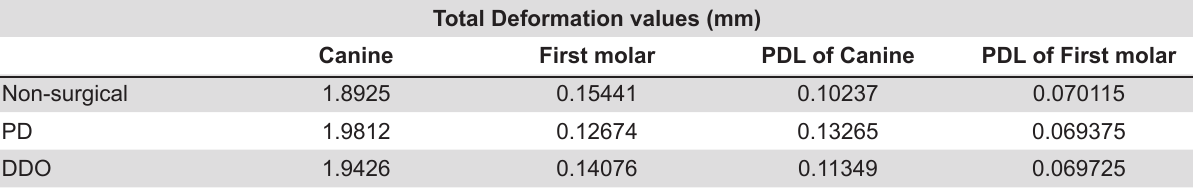
Table 1- Total Deformation values induced in three models